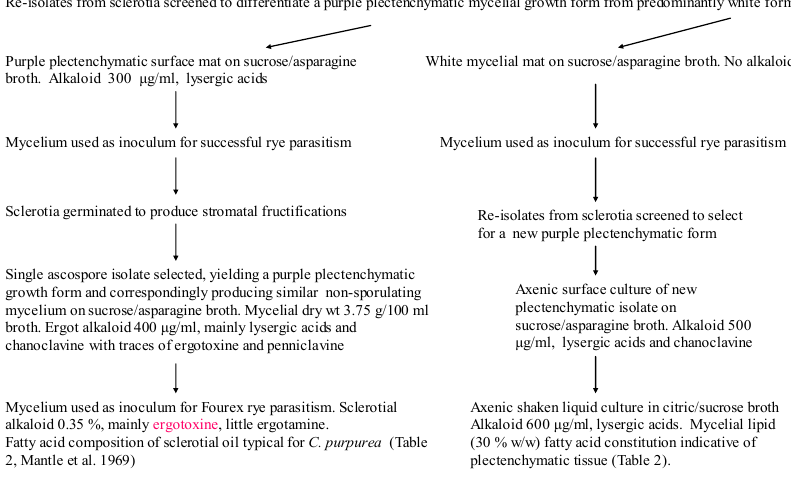
Re-isolates from sclerotiascreened to differentiate a purple plectenchymatic mycelial growth form from predominantly white forms.